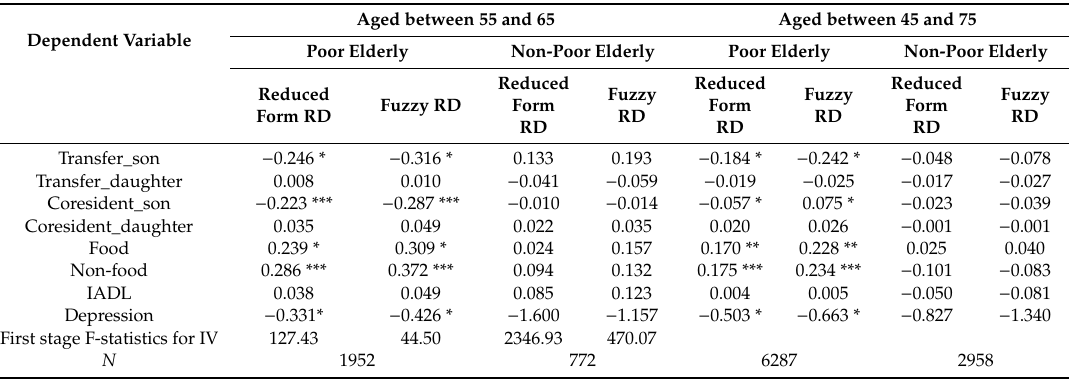
Table A1. Robustness check for alternative bandwidths.